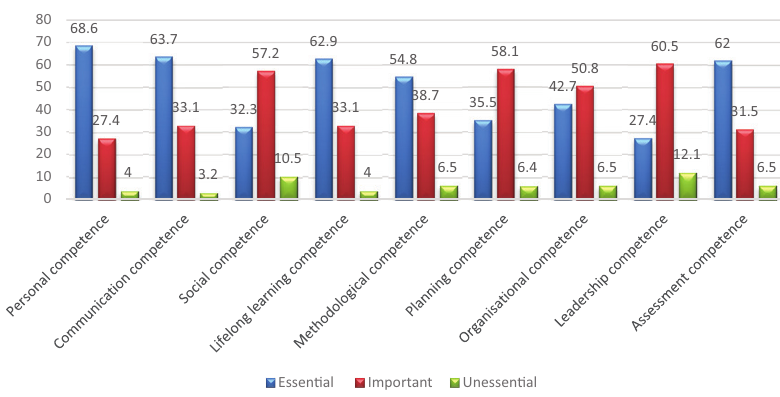
Figure 2. The importance of competences in the educational process (%) (source: created by